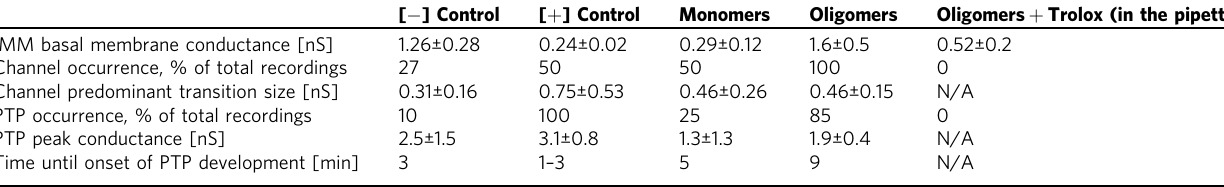
Table 1 Alpha-synuclein-induced channel activity and PTP opening in mitochondrial inner membrane